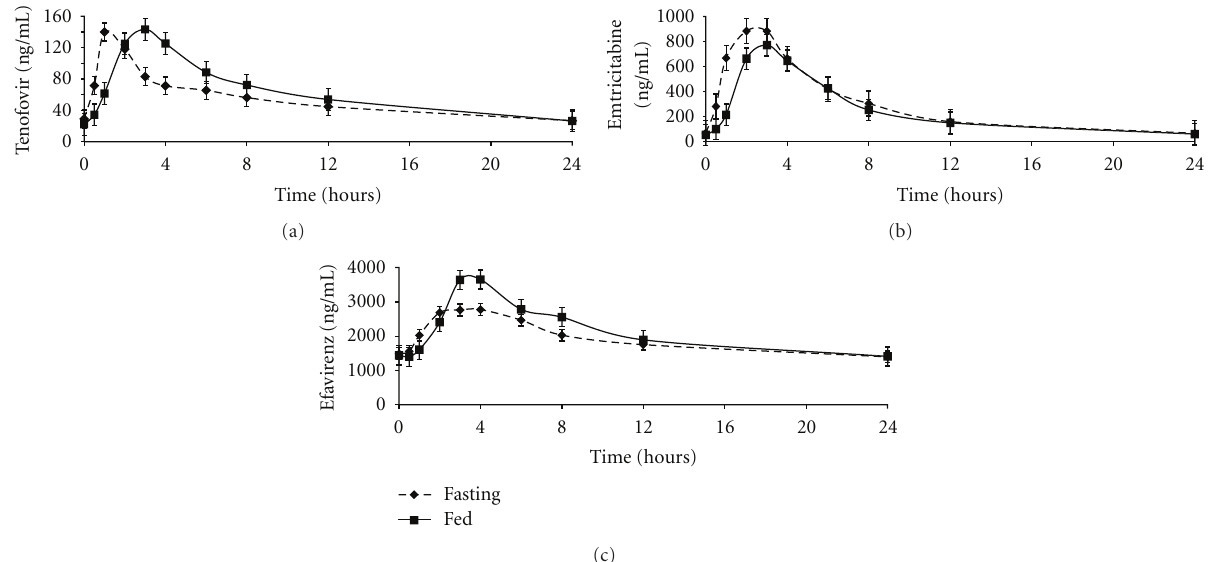
Figure 1: 24-hour plasma-concentration-time profiles of (a) tenofovir, (b) emtricitabine, and (c) efavirenz when administered in the fed and fasting states . Error bars, standard error .